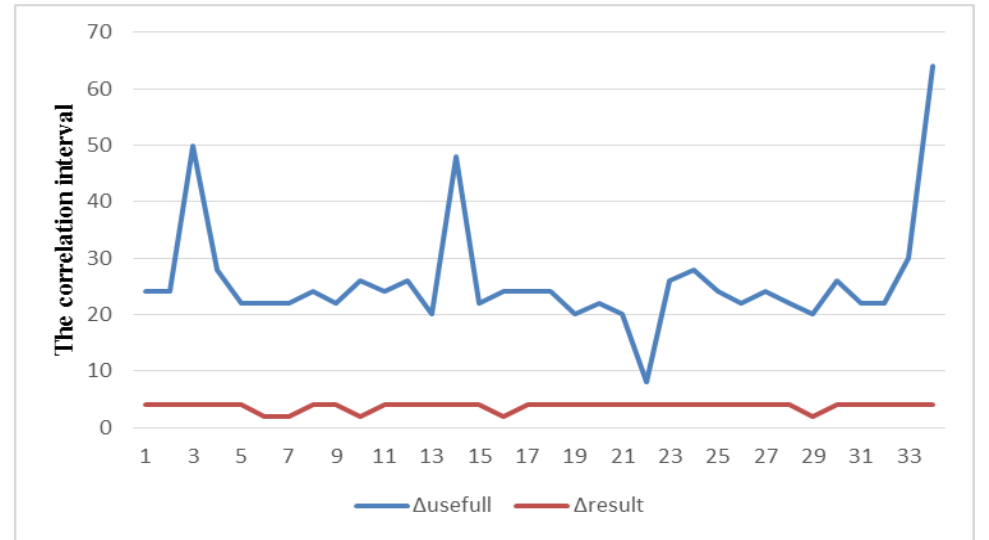
Figure 8. The correlation interval of the autocorrelation function of the legitimate traffic components (blue color) and the total traffic components (red color) at the third iteration.